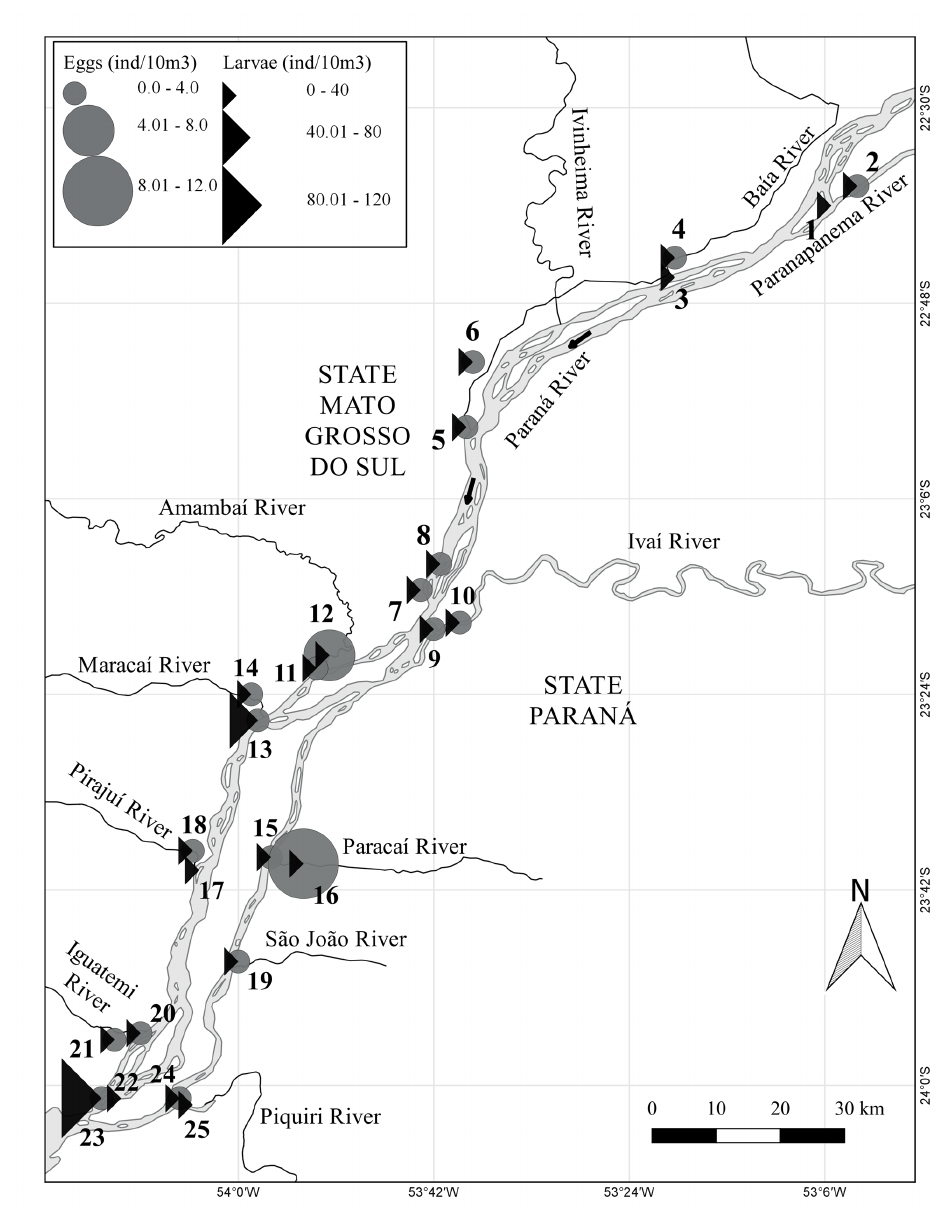
Figure 2. Spatial distribution of fish eggs and larvae (mean density) in different environments of the Upper Paraná River floodplain, between August 2013 and May 2015. 1 = MPARN; 2 = TPARN; 3 = MBAIA; 4 = TBAIA; 5 = MIVIN; 6 = TIVIN; 7 = MIVIH; 8 = TIVIH; 9 = MIVAI; 10 = TIVAI; 11 = MAMAM; 12 = TAMAM; 13 = MMARA; 14 = TMARA; 15 = MPARA; 16 = TPARA; 17 = MPIRA; 18 = TPIRA; 19 = LSAJO; 20 = MIGUA; 21 = TIGUA; 22 = MSARA; 23 = LSARA; 24 = MPIQU; 25 = TPIQU. Name of codes see Table